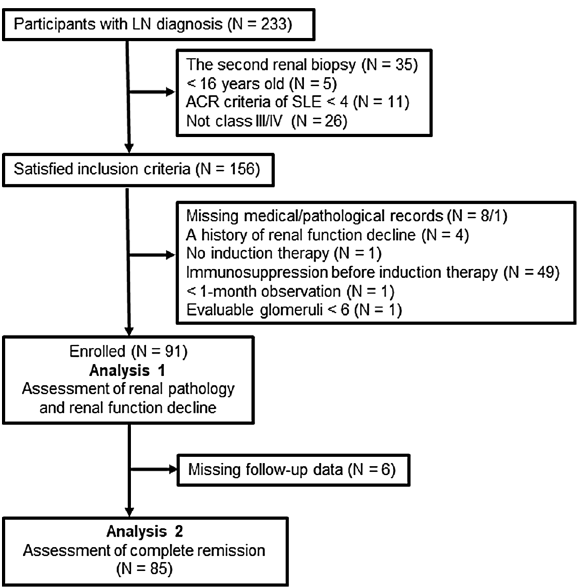
Figure 1. Flow chart of patient selection. Ninety-one patients with first-onset lupus nephritis were enrolled in this study and assessed for pathological findings and renal function decline during the observational duration (Analysis 1). After excluding 6 patients with missing follow-up data, achievement of complete remission was evaluated for 85 patients (Analysis 2). LN lupus nephritis; ACR American College of